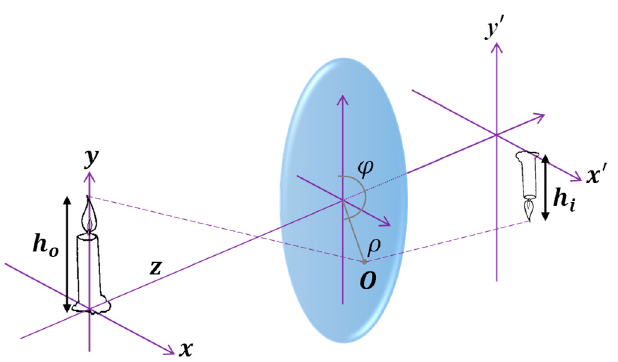
Figure 1. Relationship between the length of an object ( h (cid:2925) ) and its image ( h (cid:2919) ) in an axially symmet- rical optical system. optical